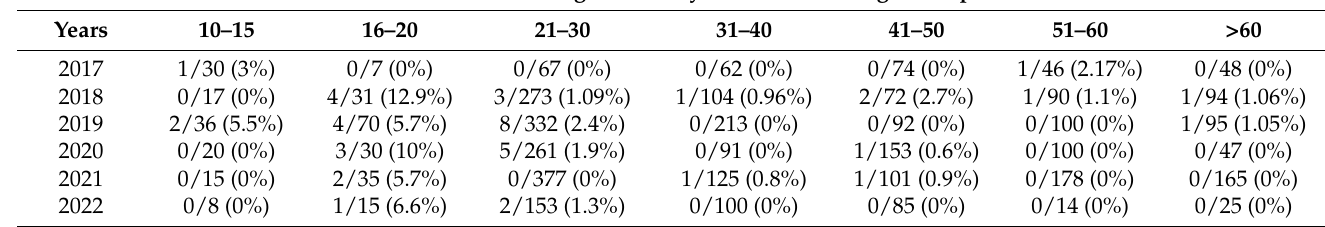
Table 2. Frequency of Salmonella spp. that were isolated from patients with enteric fever in different age groups from 2017–2022, as found in this